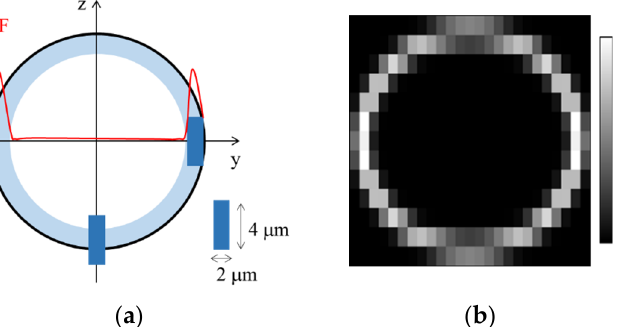
Figure A1. ( a ) Assumed particle concentration profile (red curve) for calculating the 2D distribution with spatial resolutions of 2 μ m in the y -direction and 4 μ m in the z -direction; ( b ) obtained 2D dis- with spatial resolutions of 2 µ m in the y -direction and 4 µ m in the z -direction; ( b ) obtained 2D tribution of particles. distribution of